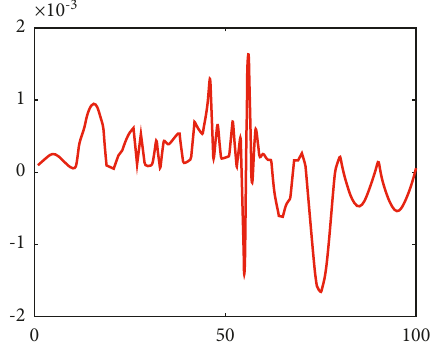
Figure 6: The error curve for the inversion result of the scatterer with